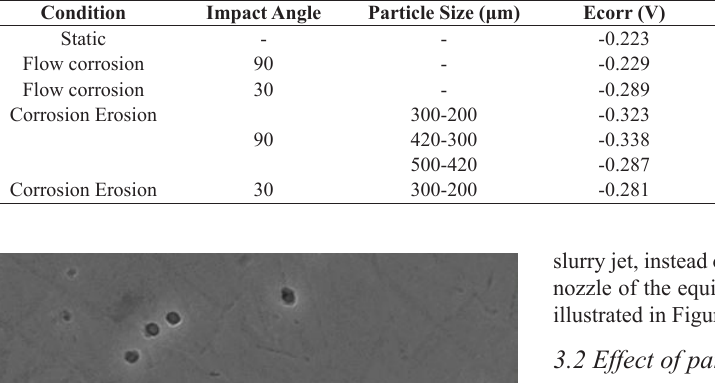
Table 2. Electrochemical parameters for different test conditions